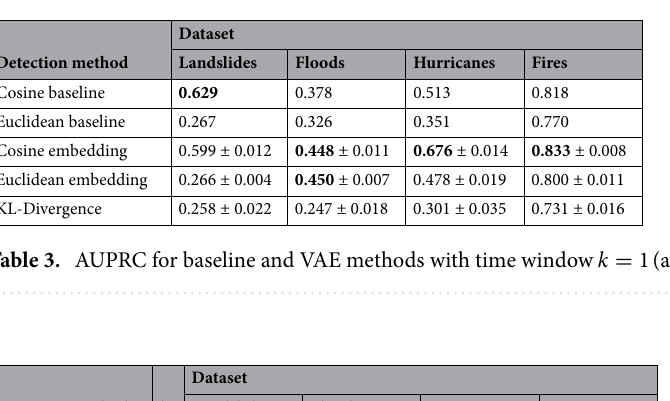
Detection method